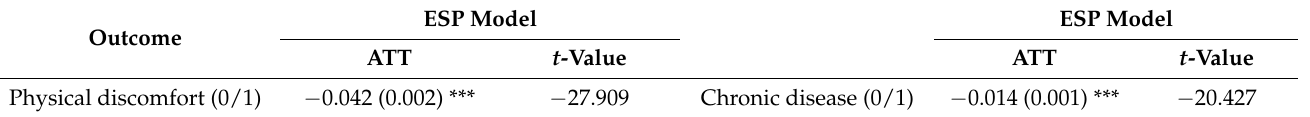
Table 7. Average treatment effects on treated using the ESP